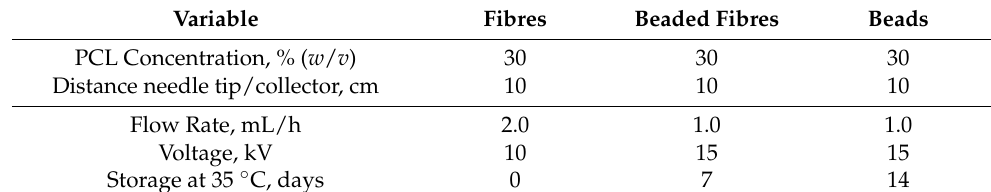
Table 1. Optimal values for sample production.